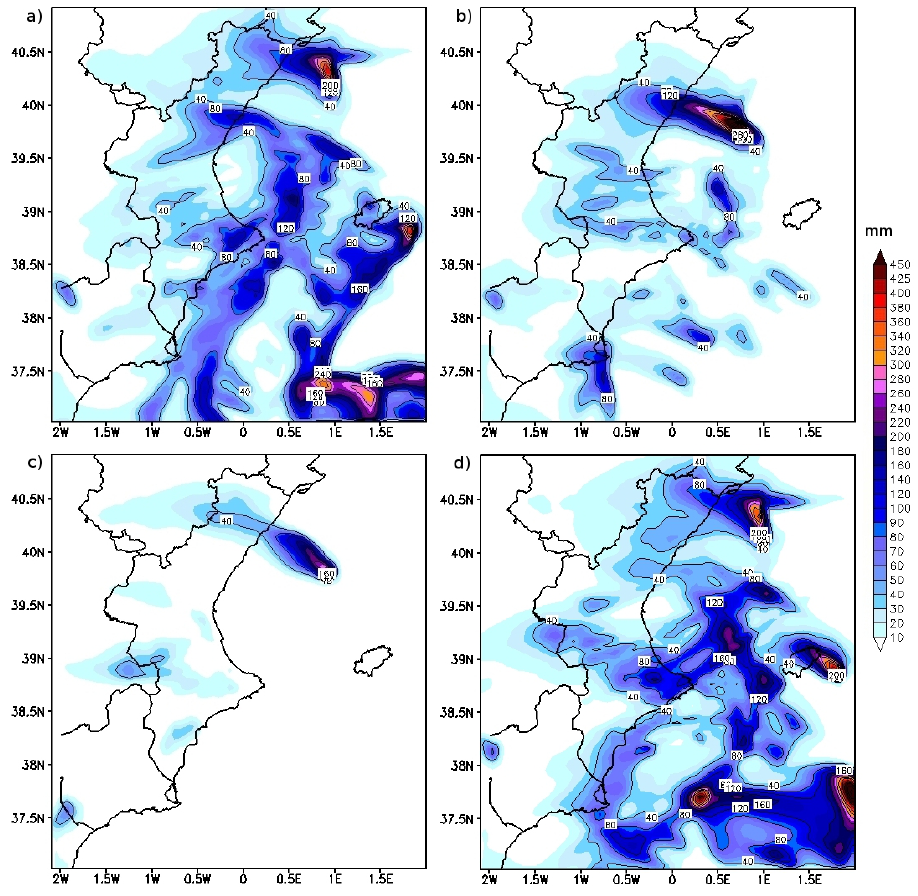
Fig. 10. RAMS grid 3 48-h accumulated resolved precipitation for KF and NoC experiments: (a) KF1, (b) KF2, (c) KF3 and (d)